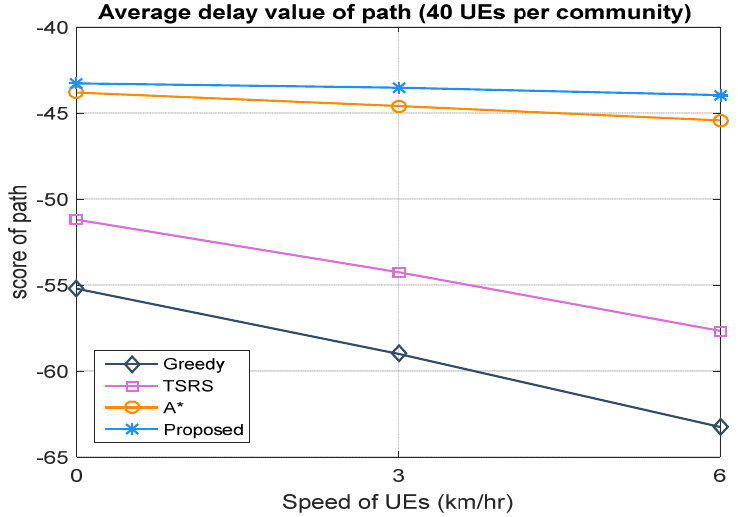
Figure 16. Hop count vs. number of UEs.